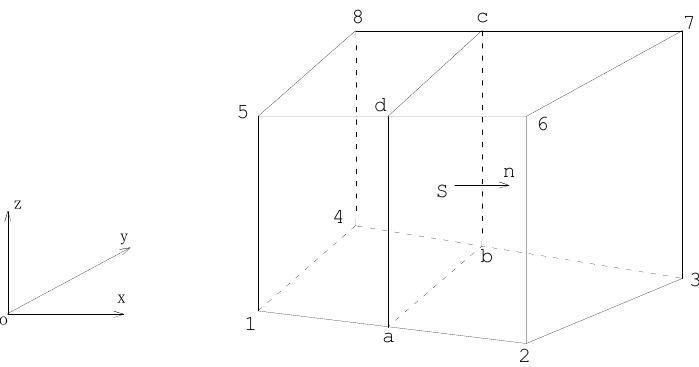
Figure 5. Simplified diagram of cross ‐ section flow calculation.